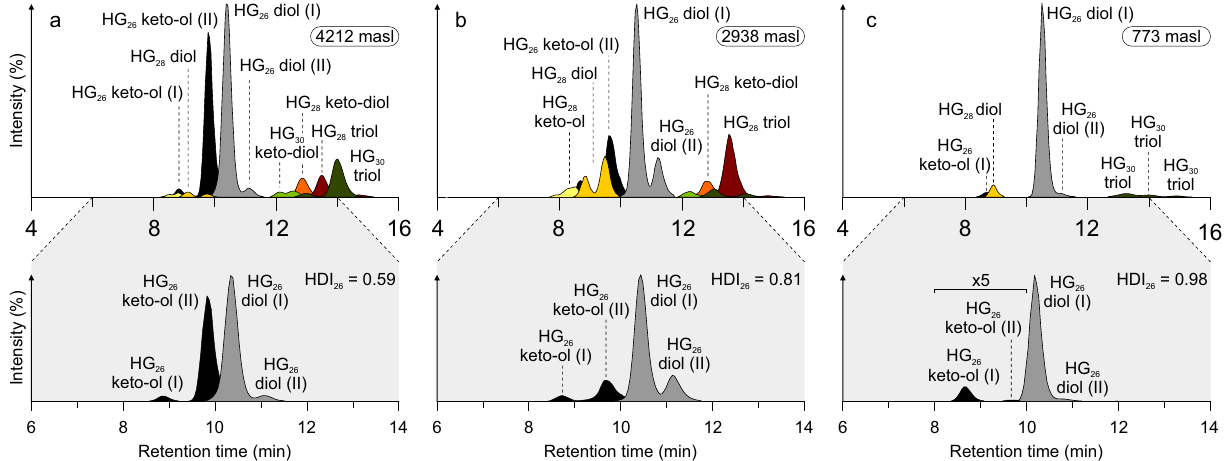
Fig. 2 Composite mass chromatograms showing the distribution of heterocyte glycolipids (HGs) in East African lake surface sediments. Representative samples include a high-elevation Lake Hohnell (4212 masl; 7.9 °C), b mid-elevation Lake Bandasa (2938 masl; 17.2 °C), and c low-elevation Lake Tanganyika (773 masl; 25.7 °C). Insets show the distribution of HG 26 diols and HG 26 keto-ols in the respective samples. Note the increase in the relative abundance of HG 26 diols compared to HG 26 keto-ols with decreasing altitude and increasing lake surface water temperature as well as the concomitant increase in HDI 26